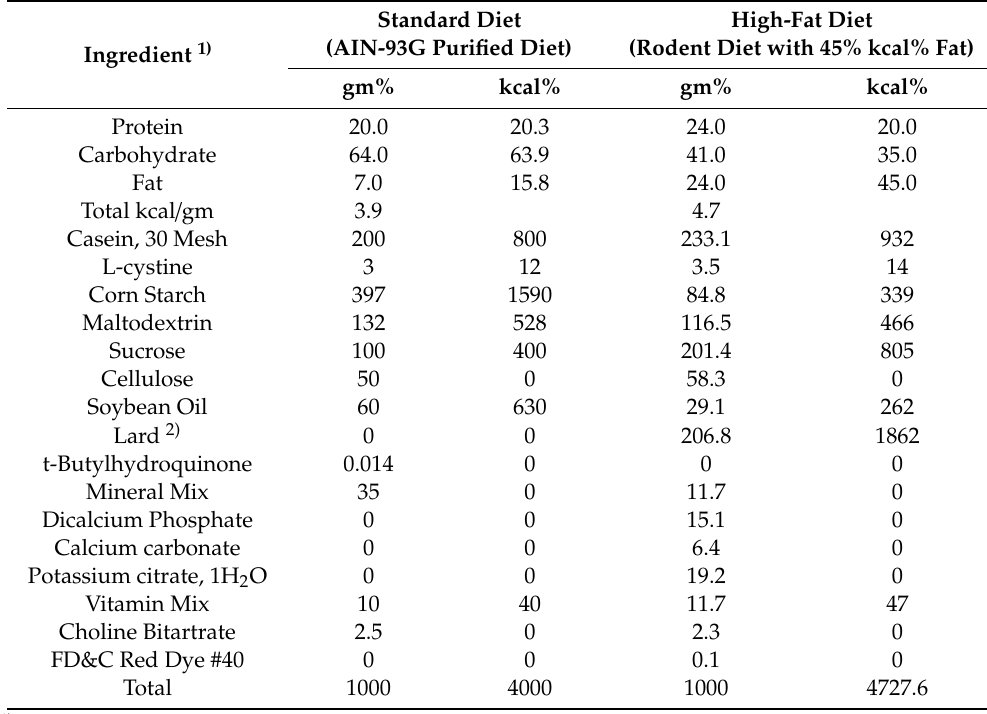
Table 2. Nutritional composition of experimental normal diet (AIN-93G) and 45% high-fat